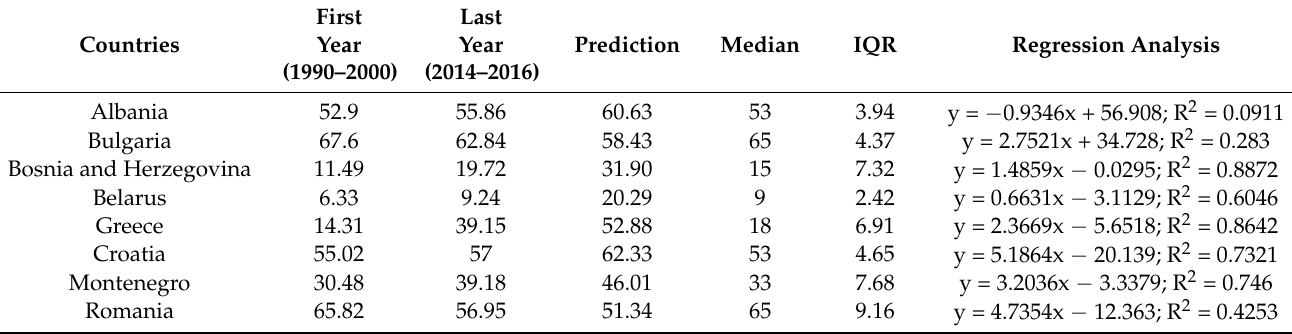
Table 1. Values of the number of general practitioners per 100,000 inhabitants—value of the first observed year, last observed year, predictive value, median value, inter-incremental difference and linear regression analysis.